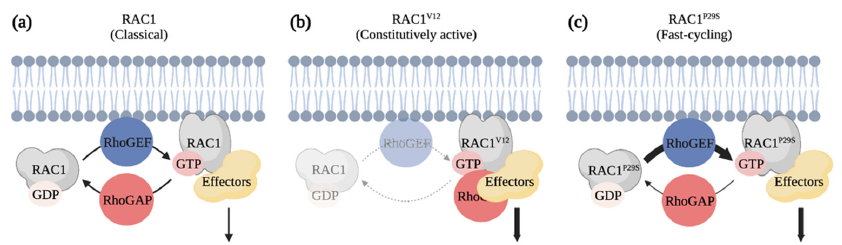
Figure 6. RAC1 P29S is a fast-cycling Rho GTPase identified as an oncogenic driver of melanoma. ( a ) Classical Rho GTPases cycle between GDP-bound inactive and GTP-bound active forms. ( b ) RAC1 V12 is defective in its GTPase activity and constitutively bound to GTP. Expression of this mutant has the potential of titrating RhoGAPs and effectors from other signaling pathways in cells. ( c ) RAC1 P29S is a fast-cycling Rho GTPase. The substitution of amino acid in the Switch I do- main leads to a gain of function that enhances RAC1-mediated signals. Created with BioRender.com, accessed on 20 August